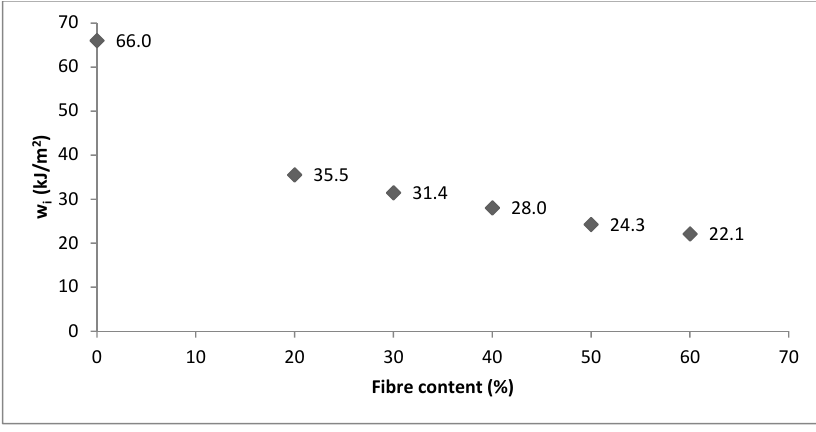
Figure 2. w i for PA11 and PA11 ‐ SGW composites regarding fiber content.